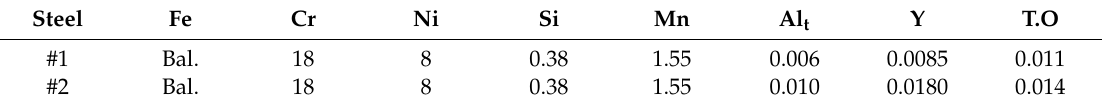
Table 1. Chemical composition of the steels